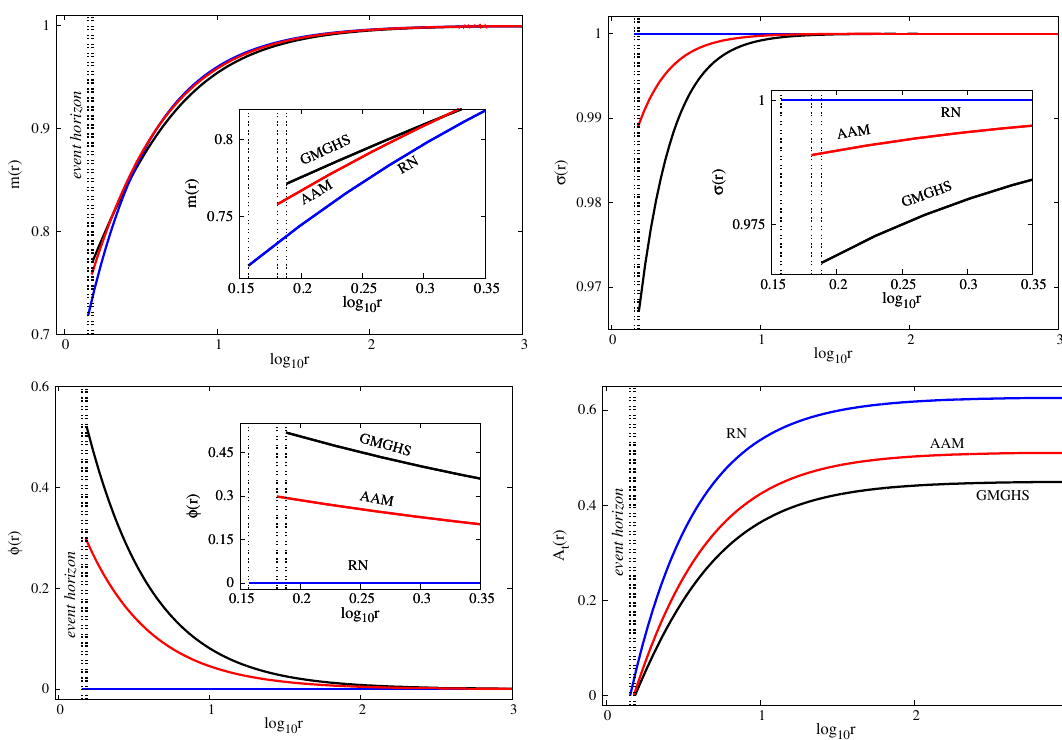
Figure 3 . The metric functions m ( r ) (top left panel) and (cid:27) ( r ) (top right panel), the scalar (cid:12)eld pro(cid:12)le (cid:30) ( r ) (bottom left panel) and the electric potential A t ( r ) (bottom right panel), for the RN BH ( (cid:11) = 1 ), a AAM solution ( (cid:11) = 100) and a GMGHS ( (cid:11) = 0), all with q = Q e =M = 0 :